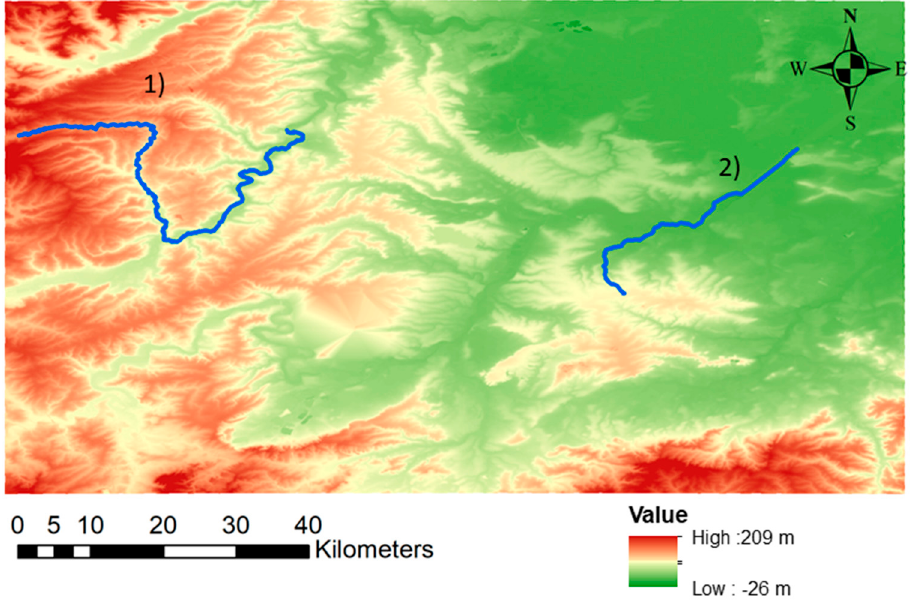
Figure 22. Location of rivers section ( 1 ) and ( 2 ) in the study area.